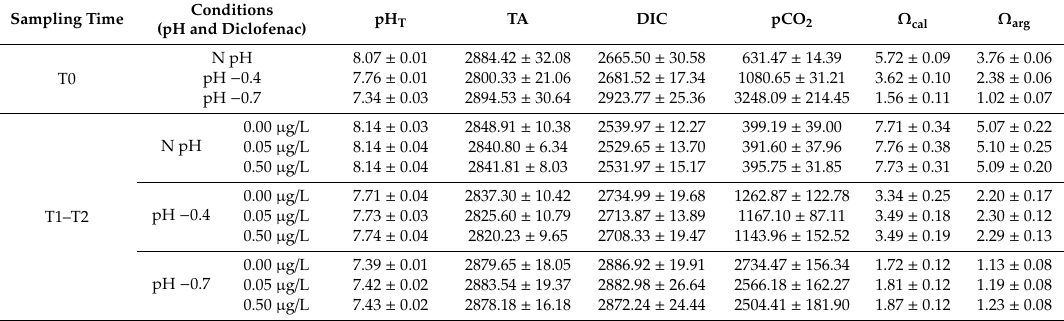
Table 1. Seawater carbonate chemistry parameters (mean values ± SE) throughout the experiment. TA = total alkalinity; DIC = total dissolved inorganic carbon; pCO 2 = CO 2 partial pressure; Ω cal = calcite saturation state; Ω arg = aragonite saturation